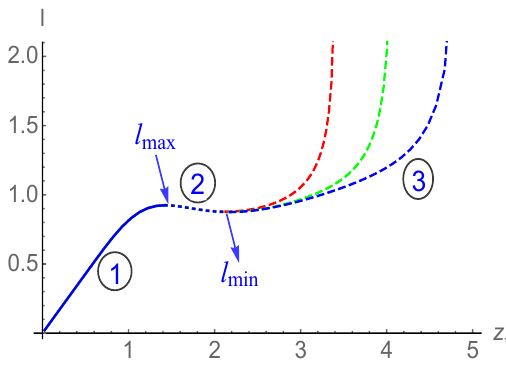
Figure 26 . (cid:1) S EE = S EE (cid:0) S EE vs ‘ con discon behaviour in the small black hole background. Here (cid:22) = 0 and red, green and blue curves cor- respond to T=T c = 0 : 9, 0 : 8 and 0 : 7 respectively. In units